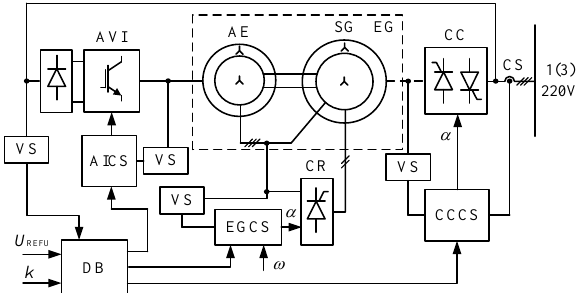
Figure 4. Functional diagram of MCVS of stabilizing system of the electrical output voltage parameters